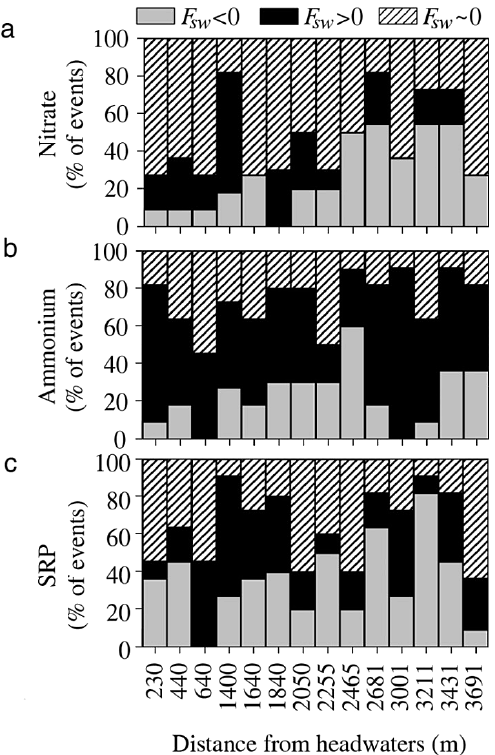
Figure 6. Frequency of dates for which F sw < 0 (gross up- take < release), F sw > 0 (gross uptake > release), and F sw ∼ 0 (gross uptake ∼ release) for (a) nitrate, (b) ammonium, and (c) sol- uble reactive phosphorus for the 14 contiguous segments along the study reach from August 2010 to December 2011 ( n = 11). The fre- quency is expressed as number of events in relative